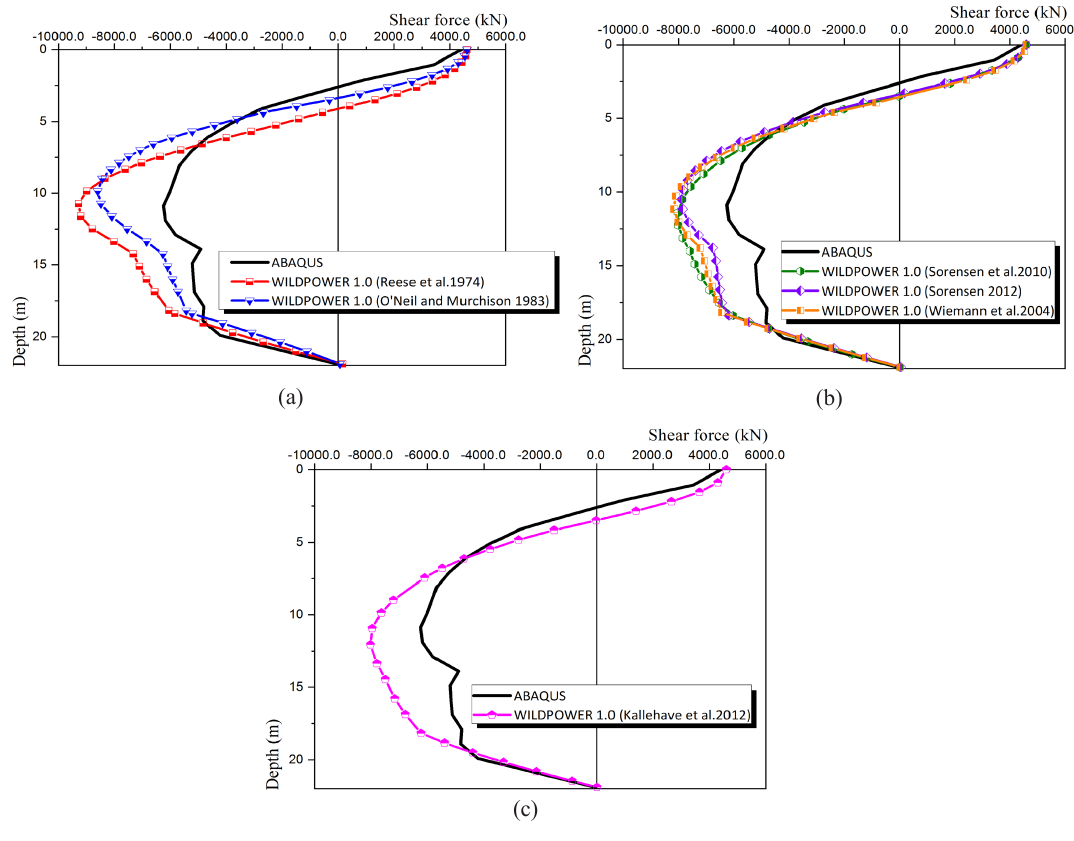
Figure 6. Profiles of shear forces.